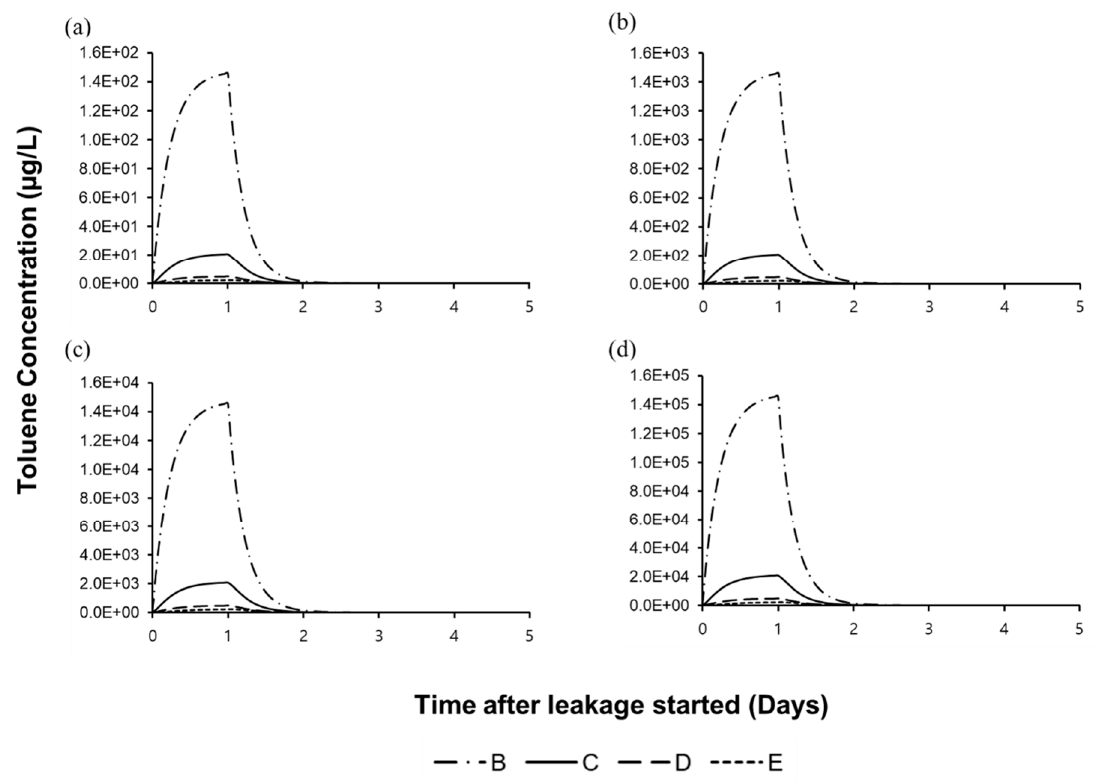
Figure 3. Concentration of toluene in the Jeonju River for ( a ) 30 kg spill, ( b ) 300 kg spill, ( c ) 3000 kg spill, and ( d ) 30,000 kg spill of toluene. Lines B, C, D, E means the name of each segment.